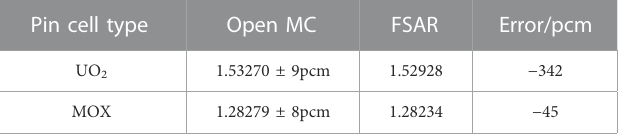
TABLE 1 JAEA pin cell eigenvalue. Pin cell type